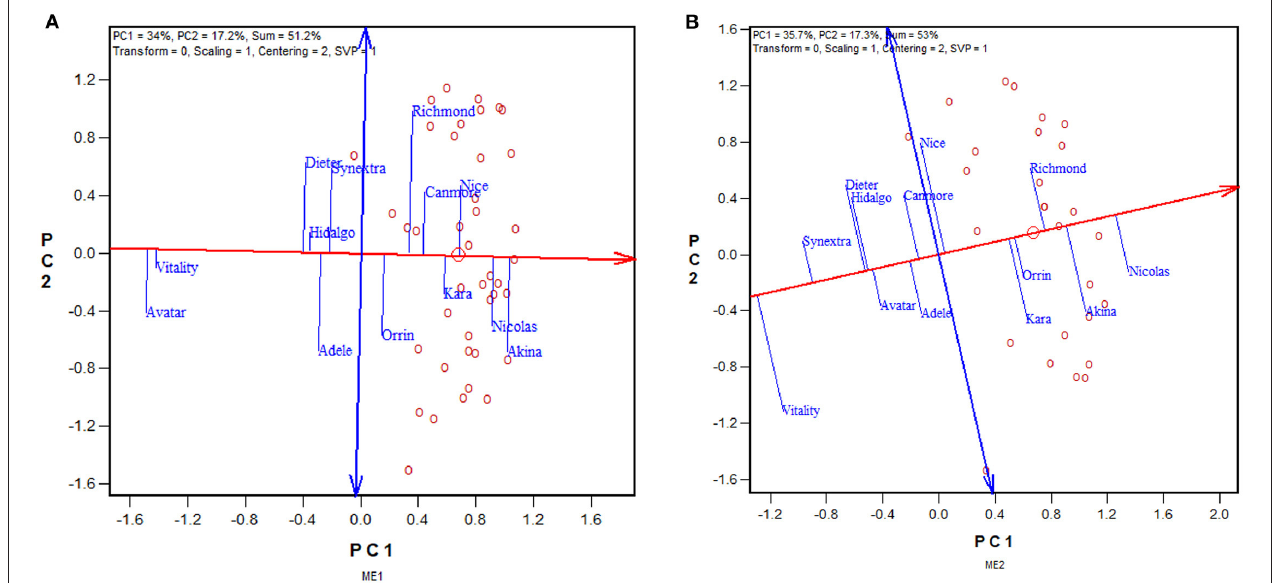
FIGURE 6 | GGE biplots to show the mean yield and instability of 13 oat cultivars in (A) mega-environment 1 (ME1) and (B) mega-environment 2 (ME2), across 2013–2019. See Figure 4 and associated text for the definitions of ME1 and ME2. PC1 and PC2 are the first two principal components from singular value decomposition of trial-standardized yield data (“Centering 2,” “Scaling 1”). The singular values were entirely partitioned to the genotypic scores (“SVP = = proper genotype evaluation. The trials are represented by “o” for clarity. The red line with a single arrow is the average environment axis (AEA), the arrow pointing to higher mean yield. The blue line with arrows on both ends is the instability axis, the arrows pointing to greater instability in either